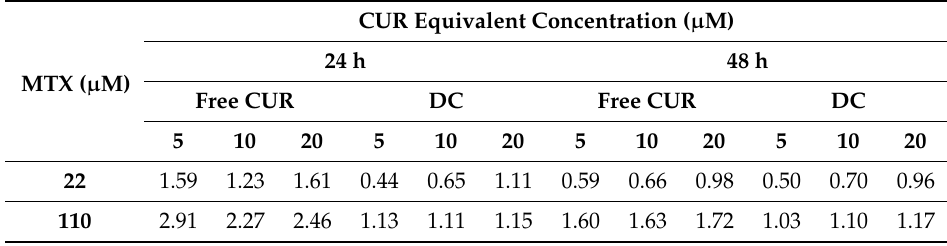
Table 1. Combination index of MTX / CUR (or DC)